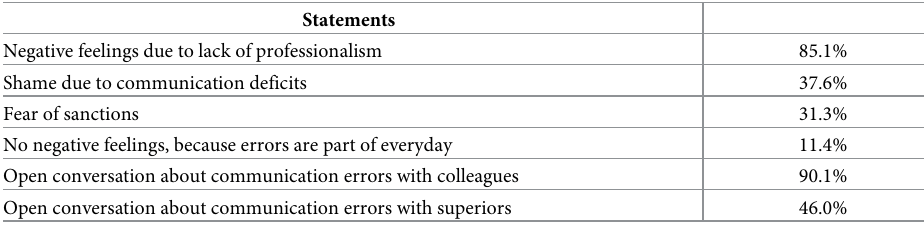
Table 5. Effects of poor communication when it harms patient.